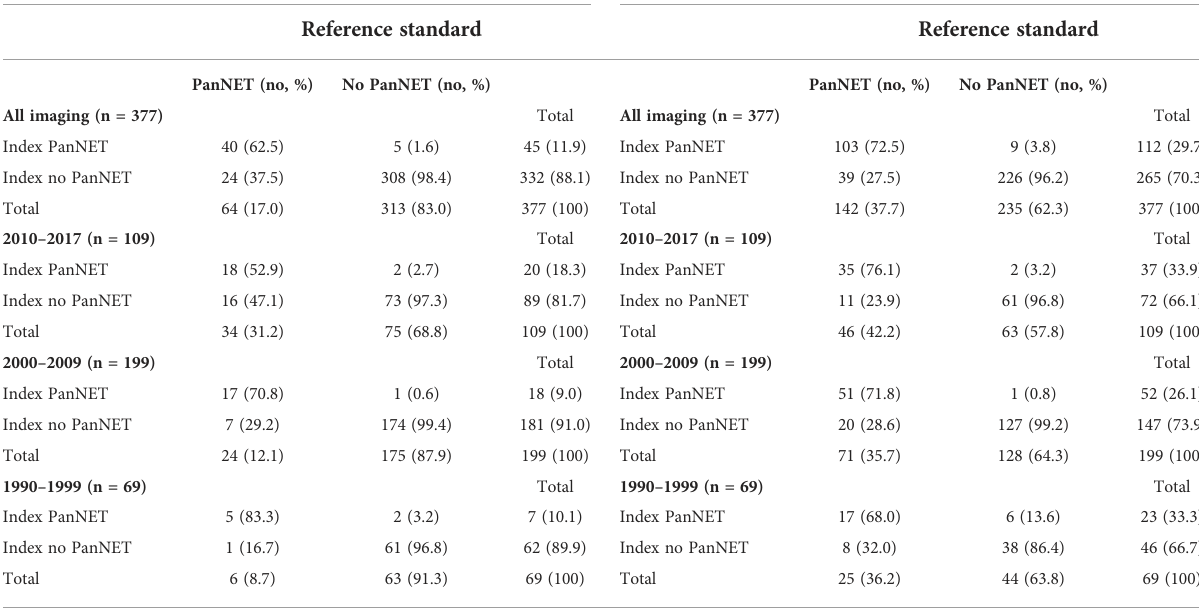
TABLE 1 Contingency tables of all imaging studies 1990 –